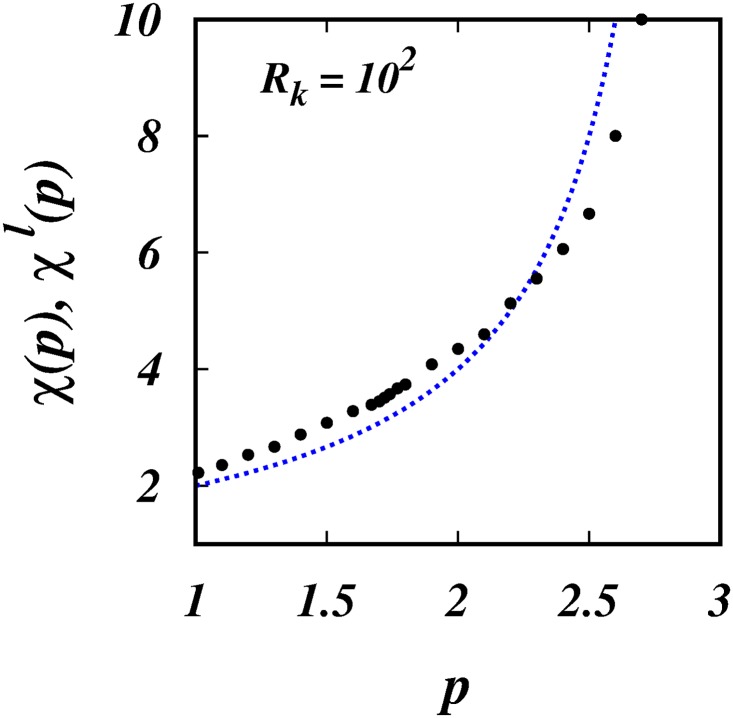
χ(p), χl(p), against p for Rk = 102.The black filled circles are, χ(p)’s from the simulations. The dotted blue line is the locality scaling, χl(p) = 4/(3 − p). See Table 2.